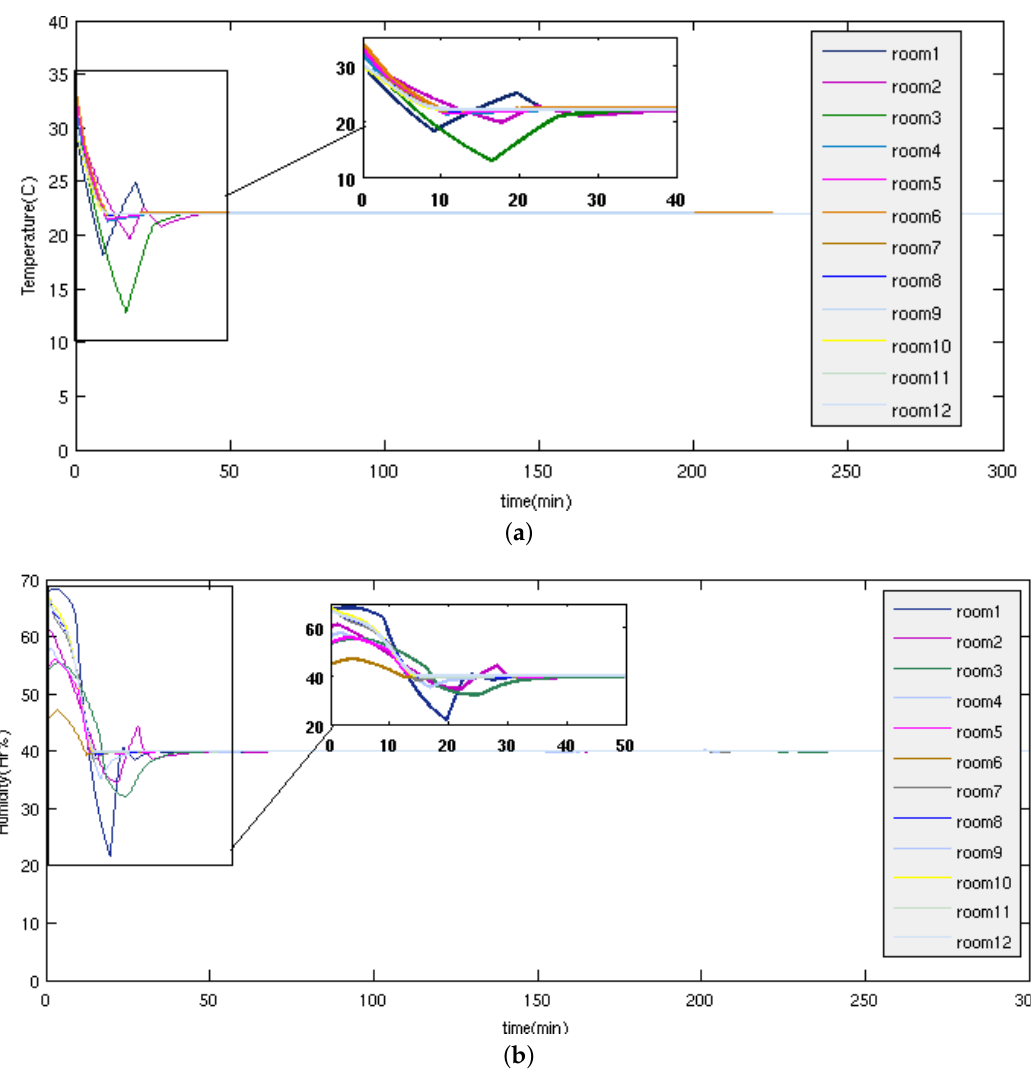
Figure 11. The numerical simulation; colored lines represent Rooms 1 to 12. ( a ) Simulation results of the fuzzy control of room air temperature with temperature disturbances and 60% packet loss. The time evolution of temperature in time for each room; ( b ) Simulation results of the fuzzy control of room air humidity with temperature disturbances and 60% packet loss. The variation of humidity (RH) in time for each room. The response in both cases includes 60% packet loss on the network and also in the presence of